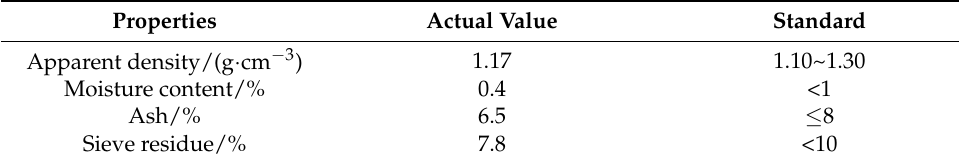
Table 3. Properties of CRM.